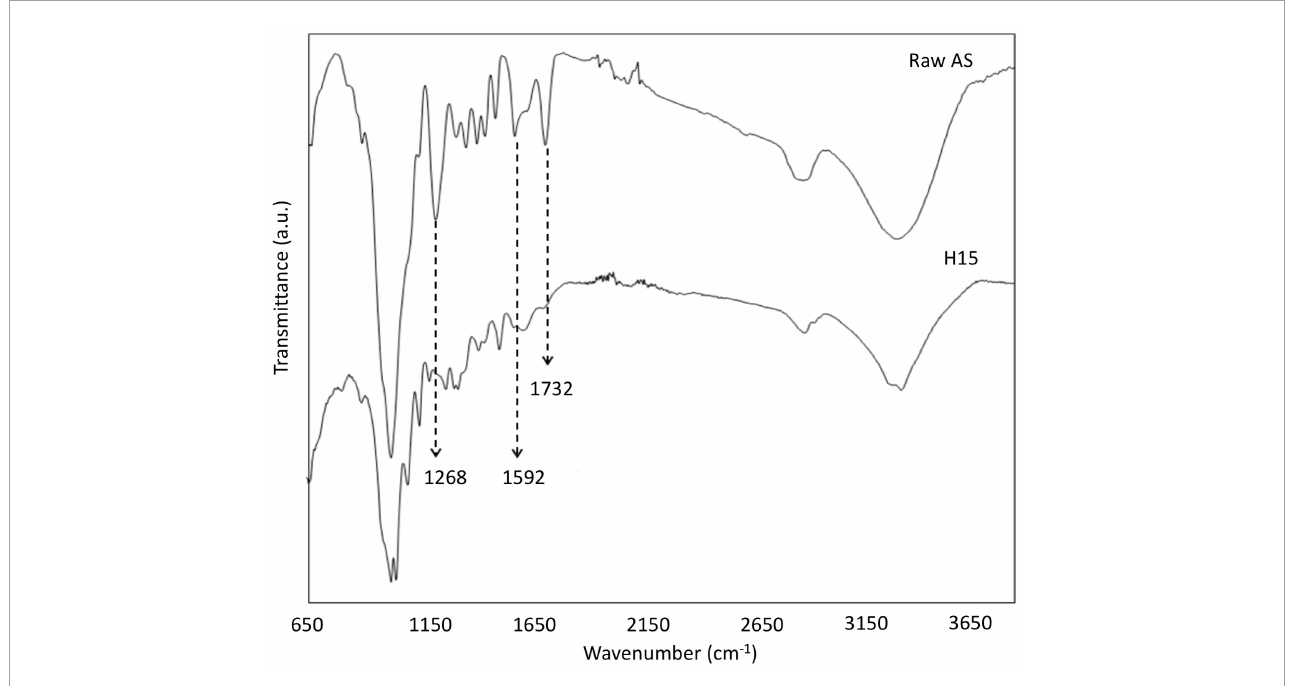
FIGURE3 FTIR spectra of raw AS and CNCs obtained using the optimal conditions found for the conventional extraction procedure (H15).